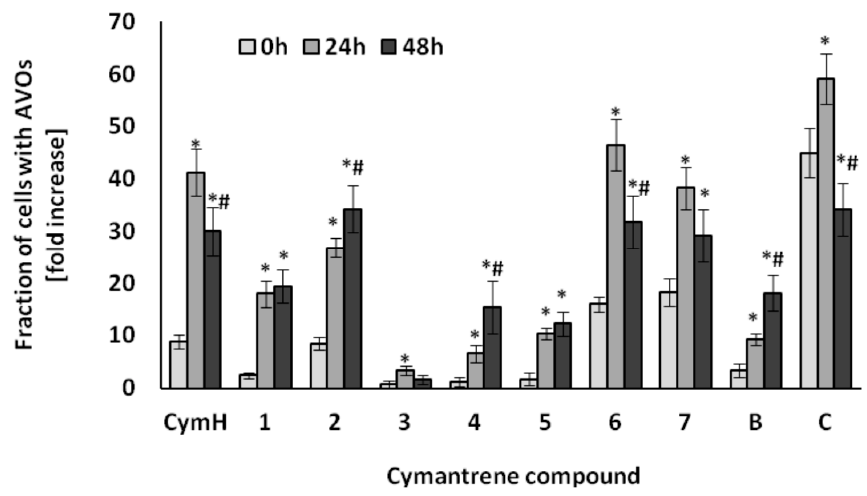
Figure 7. Induction of AVOs in SKOV-3 cells by cymantrene derivatives 1 – 7 , B , C and CymH . The cells were incubated with IC 50 concentrations of cymantrenes for 24 h under the same conditions as those applied in the cytotoxicity test and then examined immediately after the treatment (0 h time point) or cultured in drug-free medium for 24 or 48 h (24 h and 48 h time points, respectively). The time dependence of changes was statistically evaluated as described in Experimental Section (Section 4.5.2. Statistical Analysis). The fractions of AVOs containing cells at 24 h and 48 h time points were compared with corresponding fractions of AVOs containing cells at 0 h time point (* p < 0.05) and the fractions of AVOs containing cells at 48 h time point were compared with corresponding fractions of AVOs containing cells at 24 h time point (# p < 0.05). All of the changes in cells treated with cymantrenes were statistically significant in relation to untreated controls (for clarity not shown on the graph).